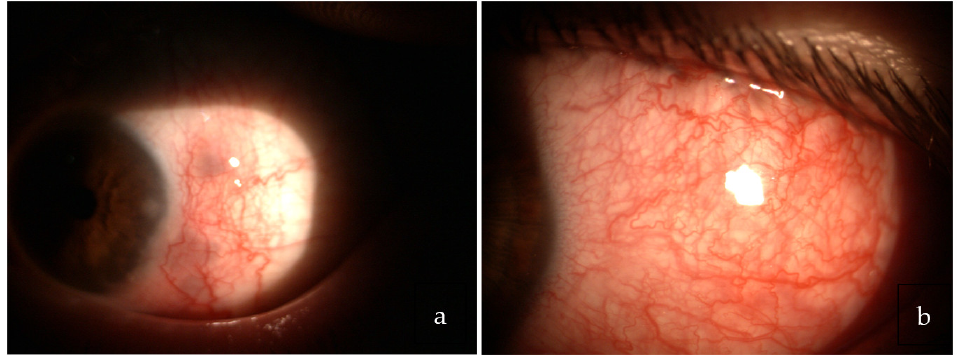
Figure 1. Nodular ( a ) and diffuse ( b ) scleritis in biopsy proven ocular